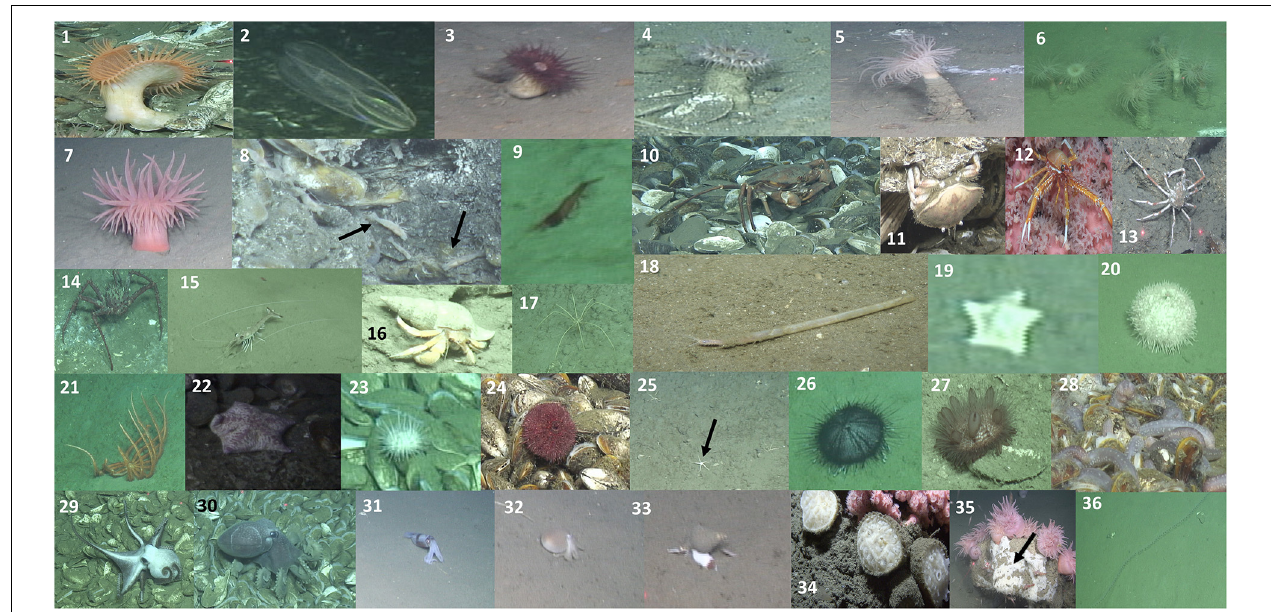
FIGURE 4 | Photographs illustrating the megafaunal categories listed in Table 2 . See Table 2 for description of each image. Black arrows in panel 8 highlight the specimens of Alvinocaris markensis , in panel 25 the ophiuroid specimens, and in panel 35 highlights encrusting